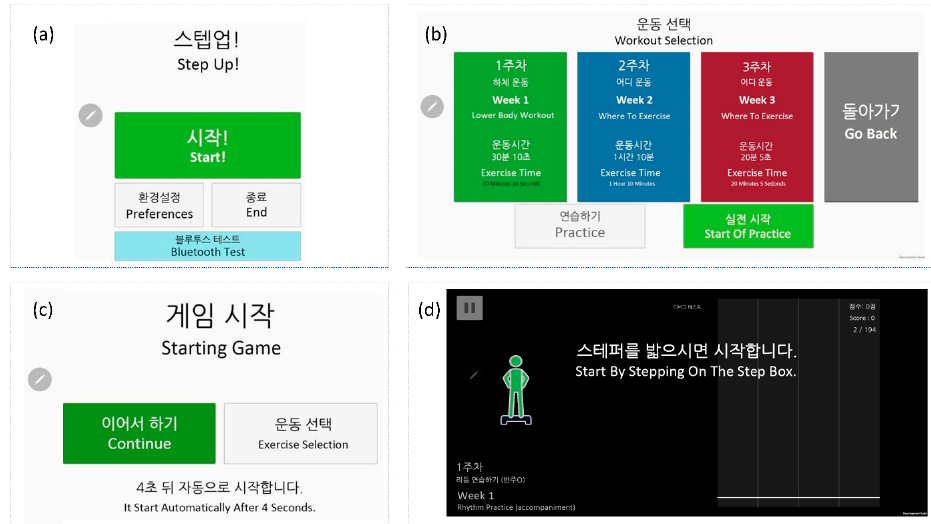
Figure 2. ( a )The “Gamified Music Steps” interface shows the application’s opening screen (Bluetooth connectivity test and start exercise), ( b ) explains the exercise/workout type selection screen, ( c ) the application screen starts the selected exercise, and, ( d ) activity start interface.